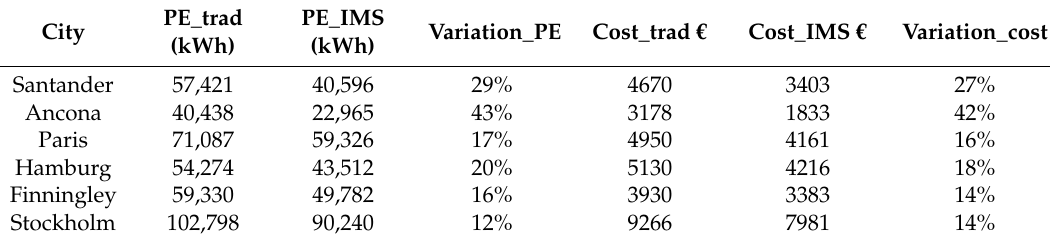
Table 9. Primary energy (PE) savings and operational cost savings of the Innova MicroSolar (IMS) plant coupled with a terraced house (4 dwellings) compared to traditional technologies (trad).